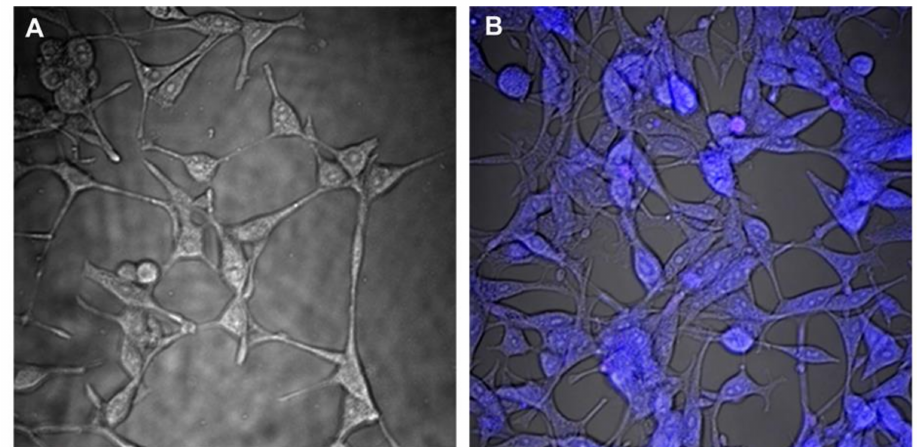
Figure 10. Confocal images for murine fibroblast NIH3T3 cell line (60 × objective, 2 × zoom) recorded at 24 h after stimulation with ( A ) “empty” 4:1 C-PUL / DEX-A nanogel (control); and ( B ) 4:1 C-PUL / DEX-A system with encapsulated piroxicam. Excitation 408 nm laser line; emission filter: 458 nm barrier filter.